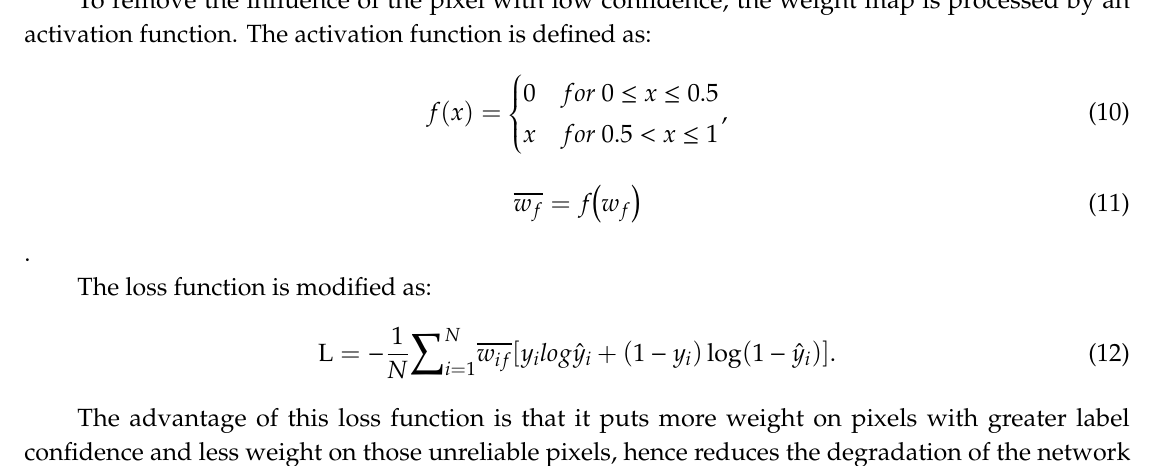
Figure 4. Training data with random noise. The segmentation network is trained with the noise data. Then the trained segmentation network is applied to predict the image of the East Lake. The prediction is refined by the pseudo label generation process. As is shown in Figure 5, the first row is the original image. The second row is the segmentation prediction by the trained segmentation network. The third row is the pseudo label generation result. The experiment shows that our designed post-processing can effectively correct the local error prediction.